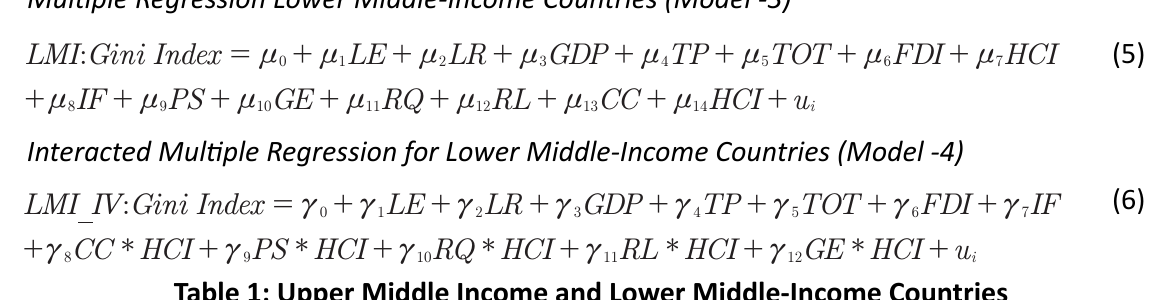
Table 1: Upper Middle Income and Lower Middle-Income Countries Upper Middle Income Countries Lower Middle Income Countries Country Country Country